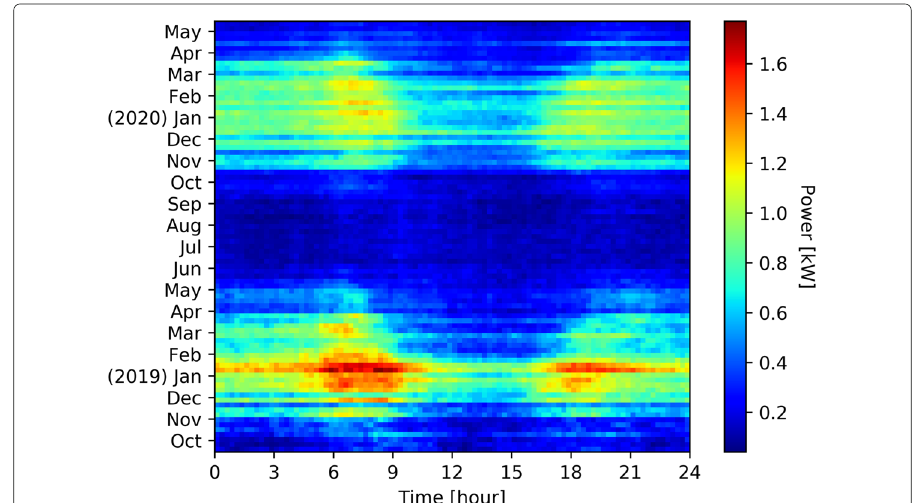
Fig. 2 Weekly space heating consumption per quarter of house of 194 households from October 2018 to May 2020. Influence of the cold season can clearly be identified. Moreover, we can observe that winter 18-19 was colder as